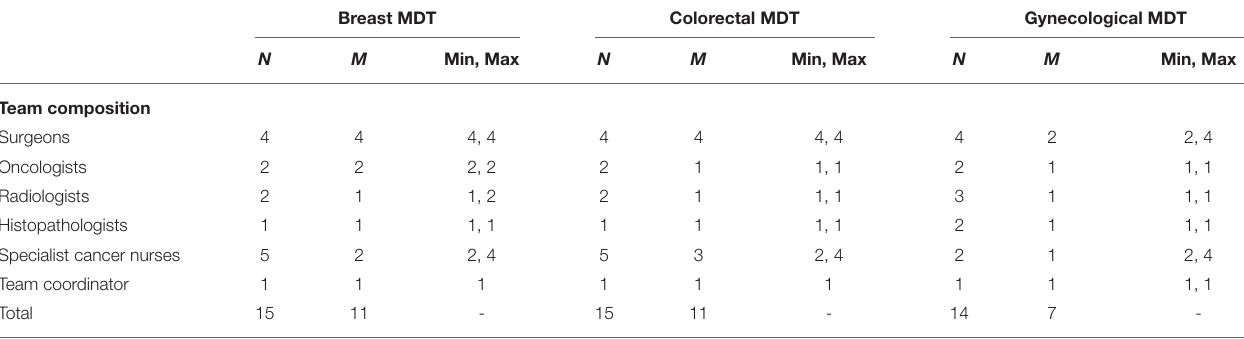
TABLE 1 | Team composition. Breast MDT Colorectal